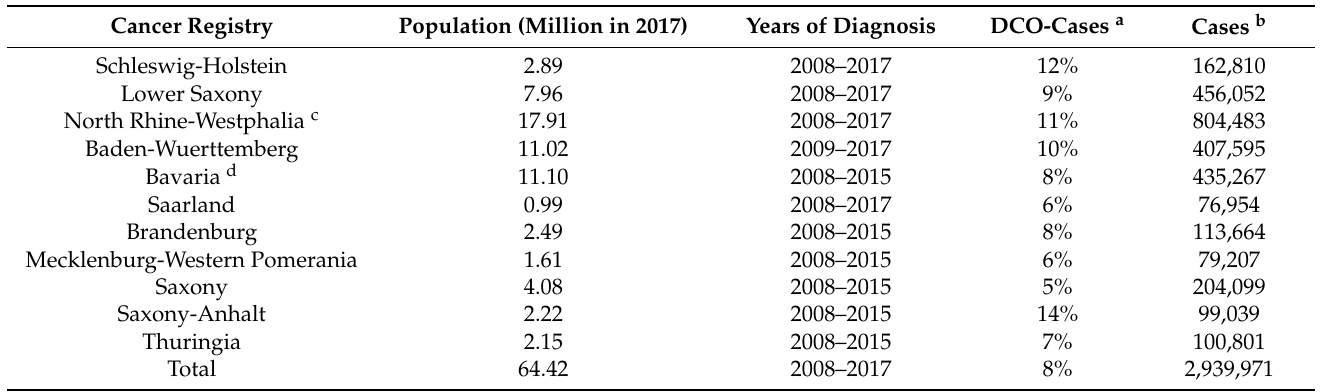
Table 1. Overview of used cancer data provided by population-based cancer registries in